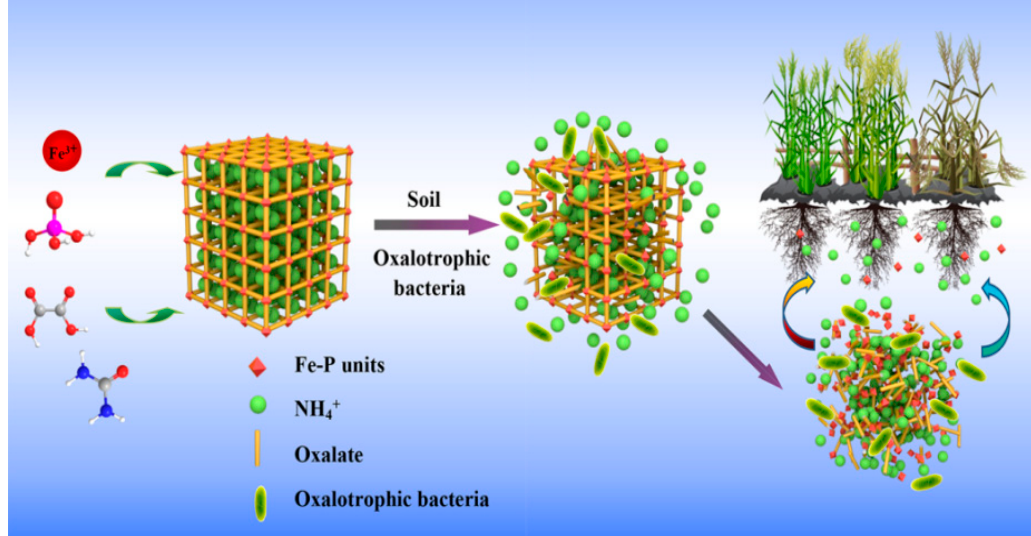
Figure 9. Schematic diagram of the MOFs’ degradation.